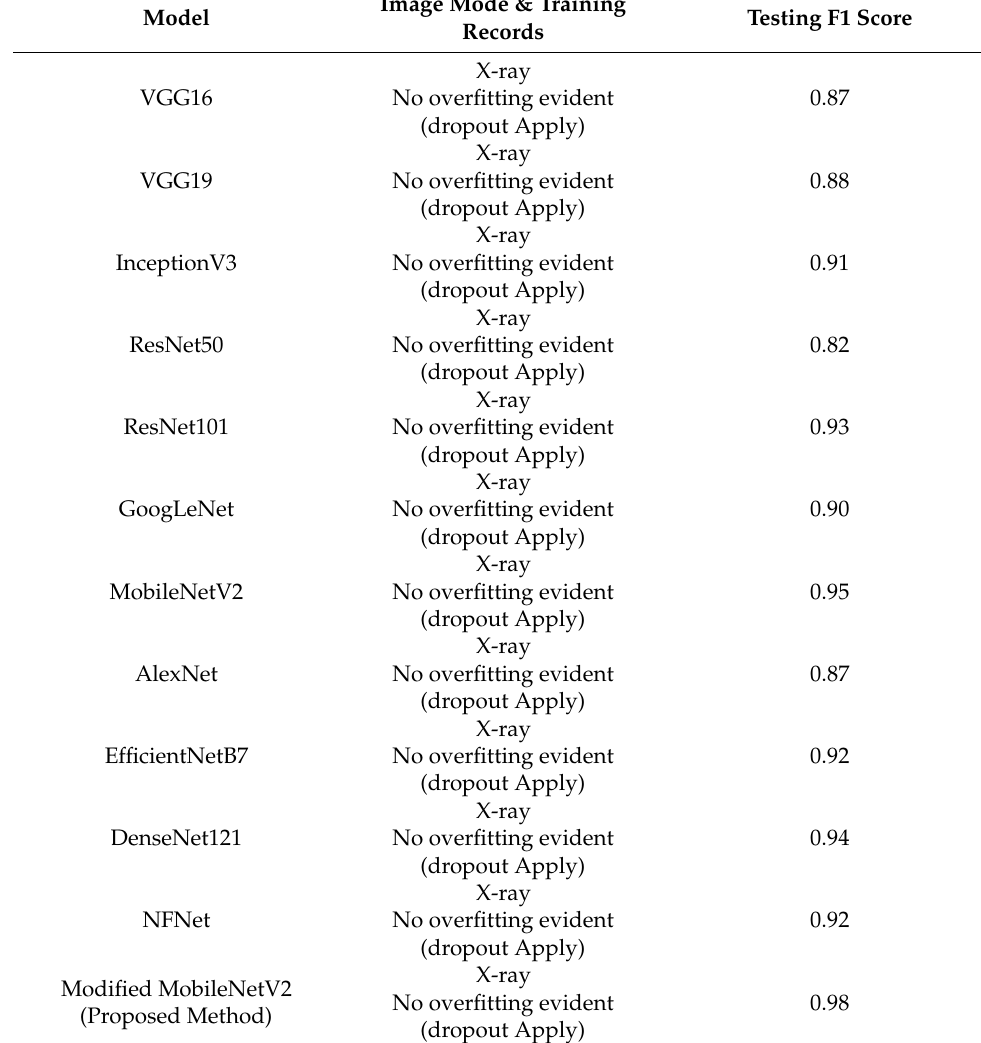
Table 6. Model performance